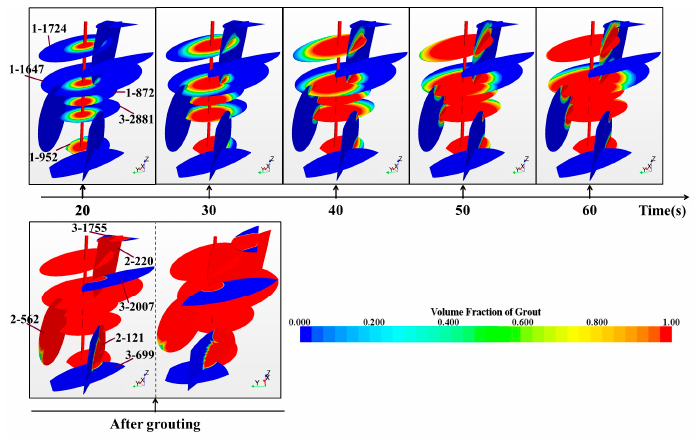
Figure 9. Grouting diffusion process.